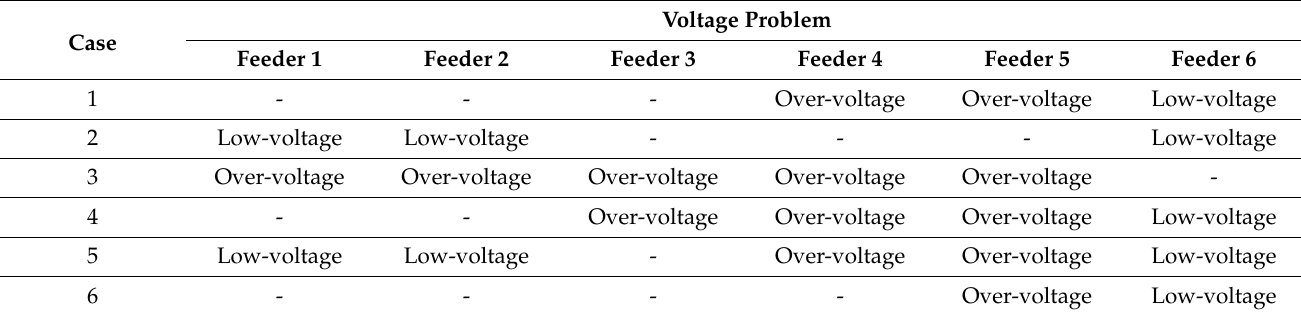
Table 4. Voltage problem according to the case studies.